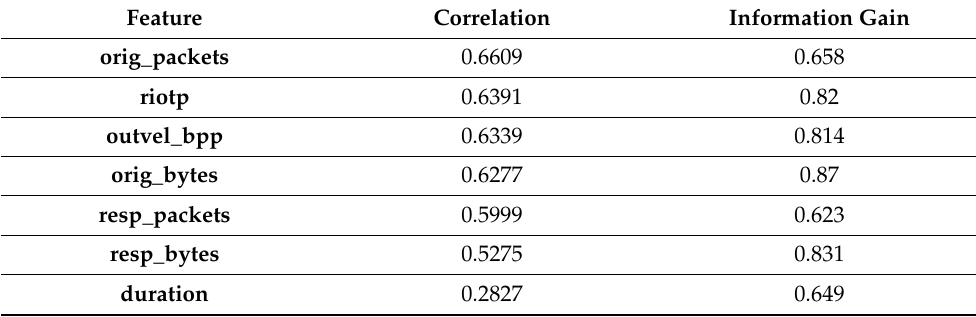
Table 4. Correlation and information gain values for each of the selected